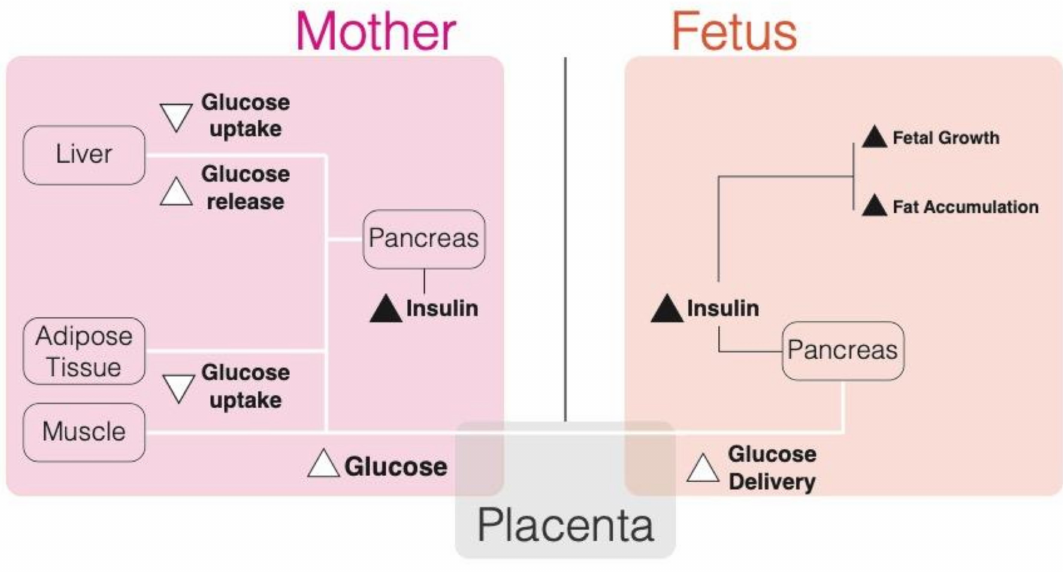
Figure 2. Glucose metabolism during pregnancy and associated consequences. White lines represent glucose transfer while black lines represent insulin